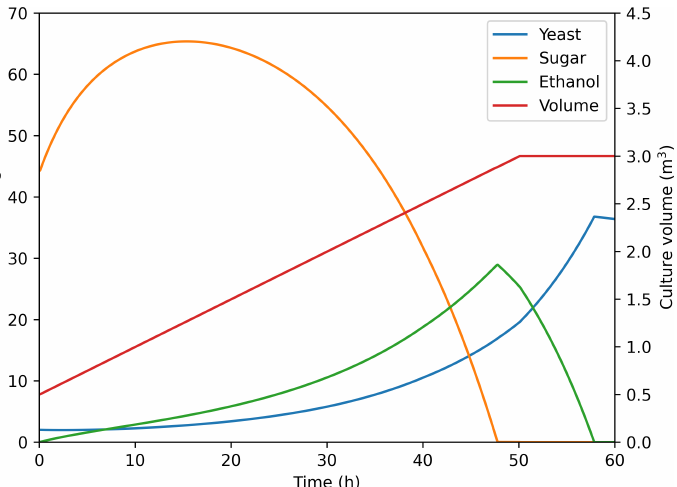
Figure 8. Cell and substrates concentration prediction for a 3 m 3 fermenter operated constant feed fed-batch